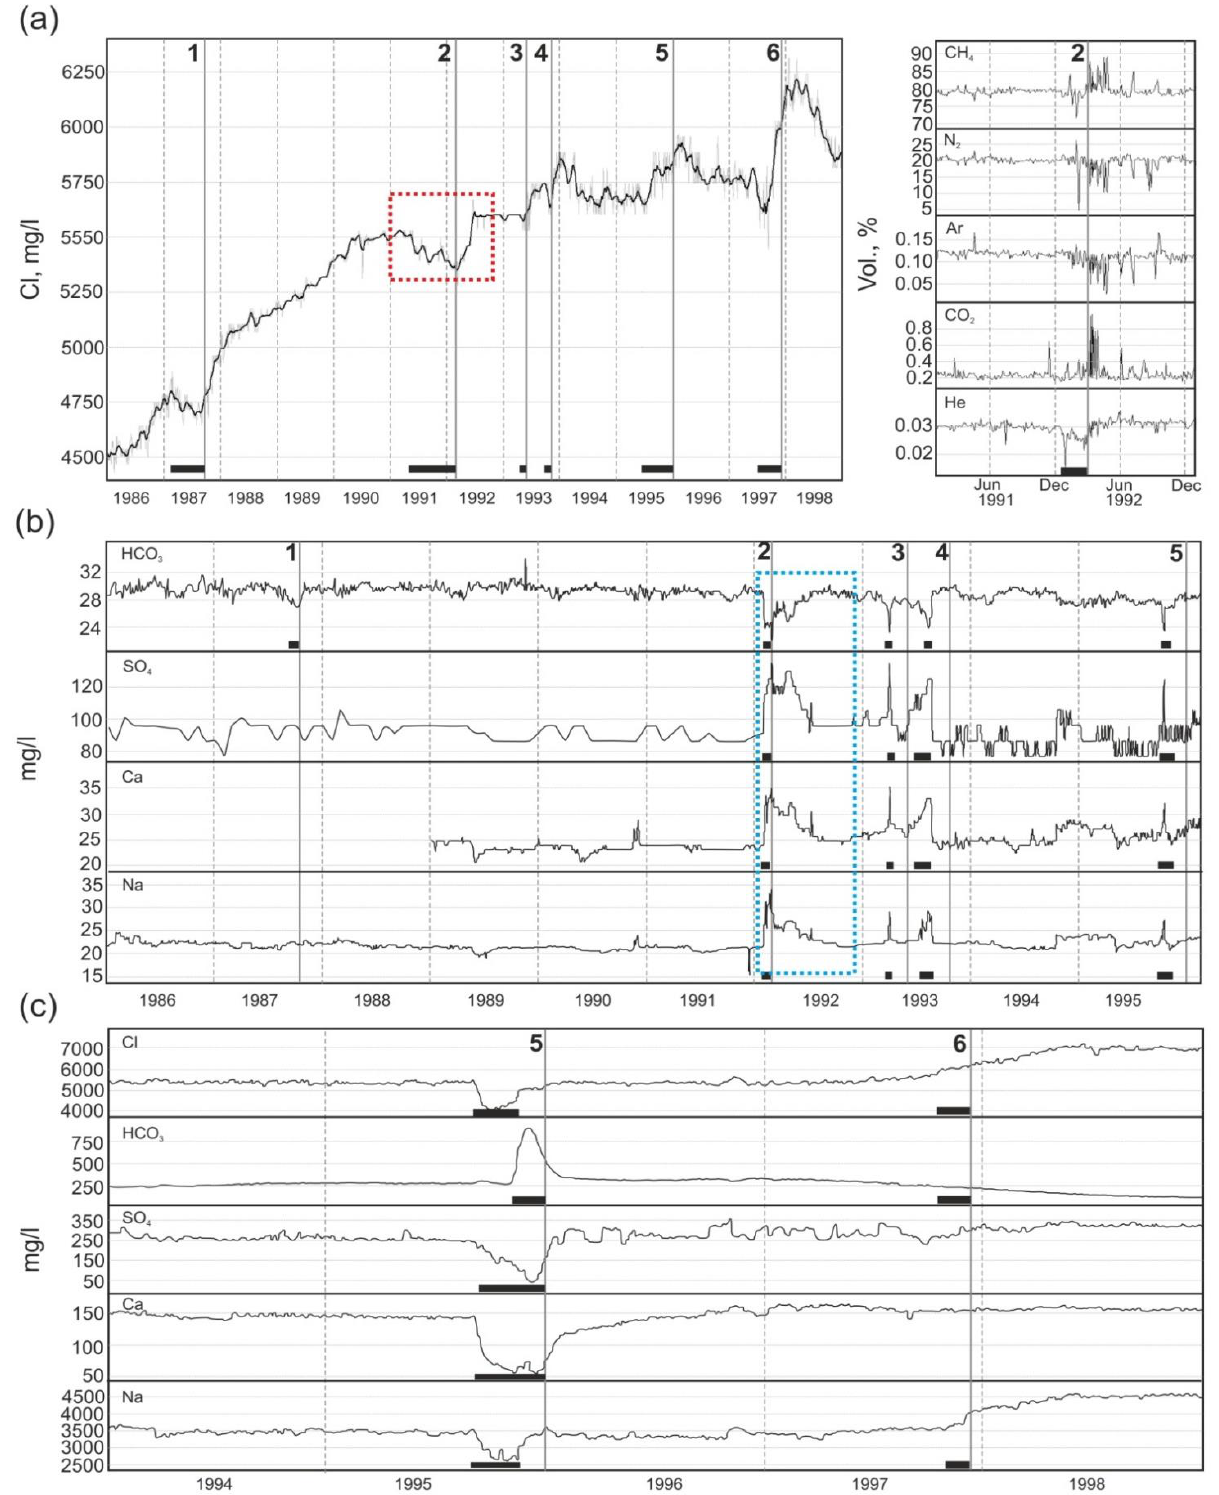
Figure 3. Anomalous effects (bold horizontal lines) in time series of groundwater ion and gas content variations from wells: ( a ) GK-1, ( b ) M-1, ( c ) G-1. Vertical lines show 1987–1997 earthquakes (Figure 1a), earthquake numbers correspond to Table 2. Red dashed rectangle highlights changes in Cl − concentration in water from well GK-1 and blue dashed rectangle highlights changes in HCO 3− , SO 42− , Ca 2+ and Na + concentrations in water from well M-1 due to earthquake on 2 March 1992 (Table 2).